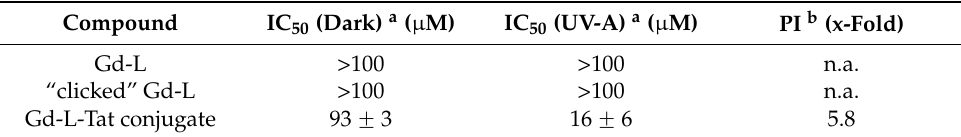
Table 2. Anti-proliferative effects of the Gd(III) complexes and Tat peptide conjugate on CAL-33 cancer cells in the dark and upon light irradiation at 350 nm for 10 min (2.58 J·cm −2 ).